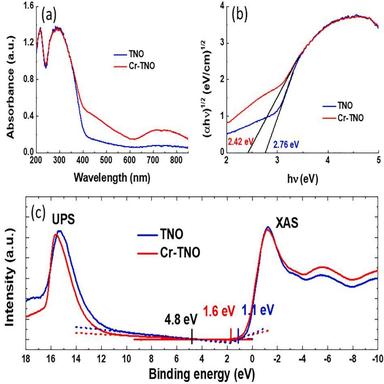
Evaluation of band gap of the as-prepared TNO. (a) UV–Vis diffuse reflectance spectra of TNO and Cr-TNO. (b) Tauc plots and (c) UPS and XAS spectra of TNO and Cr-TNO.